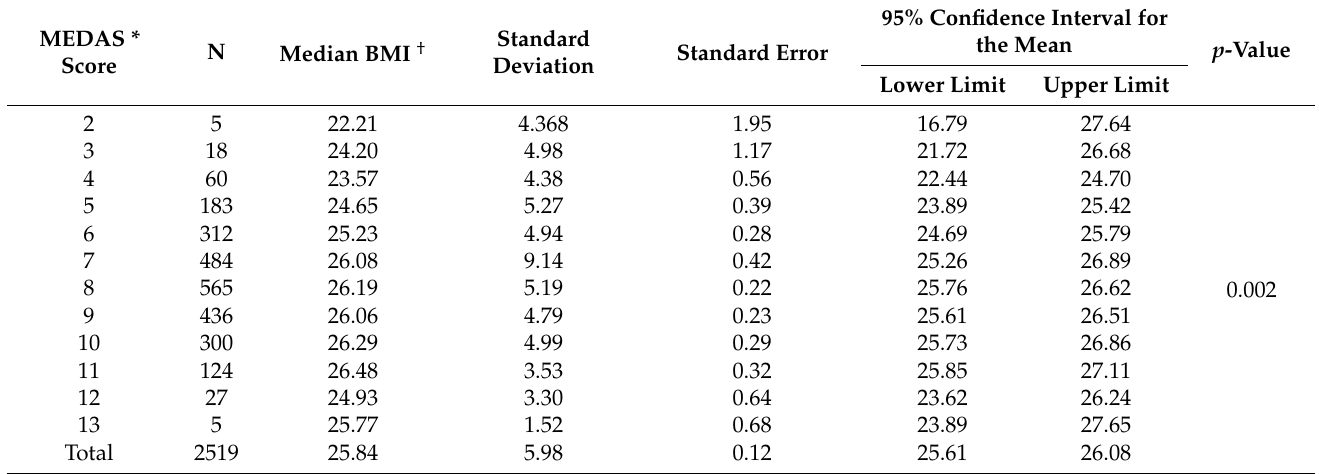
Table 3. Adherence to the Mediterranean diet in an adult population of southeastern Spain according to body mass